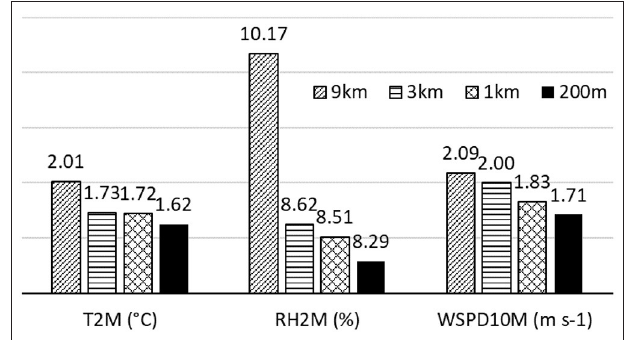
FIGURE 9 | Comparison of the root-mean-square error of WRF forecasts derived from SNUA run at different